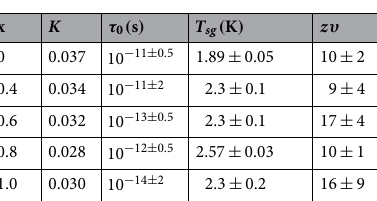
Figure 7. Temperature dependence of the real (a) and the imaginary (b) parts of the ac susceptibility for 0 member of the solid solution. Frequency vs. freezing temperature is fit to a different frequencies for the x = dynamical power law in the inset of (a) . The inset in (b ) shows the evolution of d χ ′′ dT as a function of frequency.